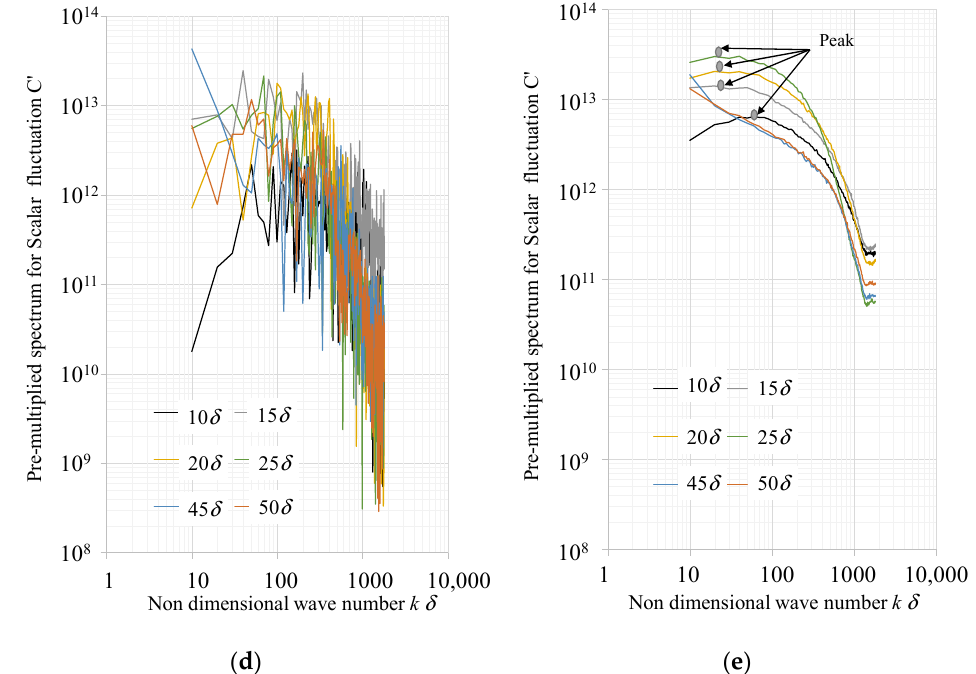
Figure 6. Two-dimensional power spectrum density (2D PSD) of concentration fluctuation fields. ( a ) Analysis procedure and averaged spectral density distribution. ( b ) PSDs on 45° line indicated as a red line in the images of ( a ). ( c ) Same as ( b ) but for the ensemble-averaged PSDs. ( d ) Same as ( b ) but for the pre-multiplied spectrum of PSD for scalar fluctuation. ( e ) Same as ( b ) but for pre-multiplied spectrum of PSD.